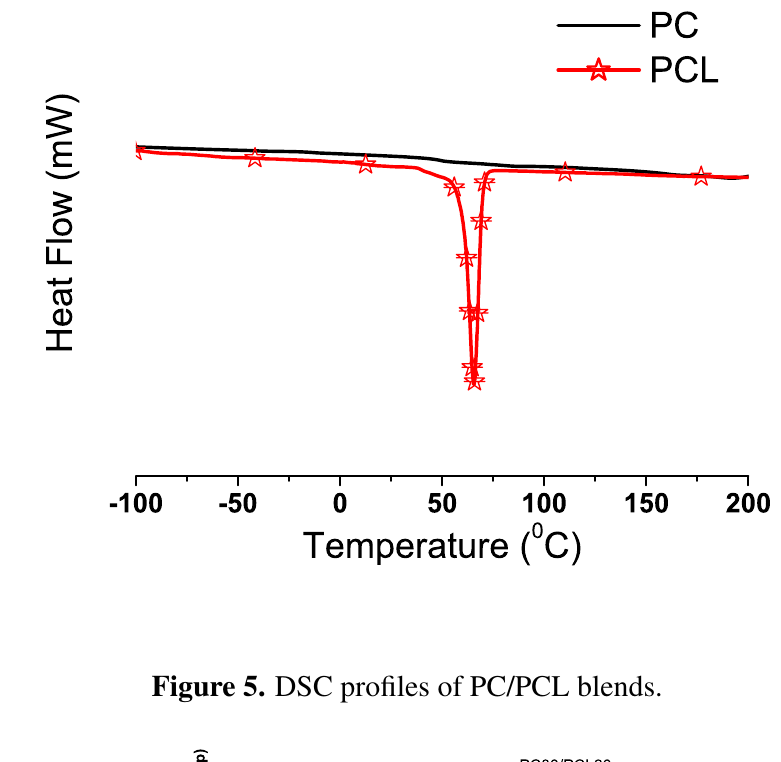
Figure 4. DSC profiles of PC and PCL (exothermic up).